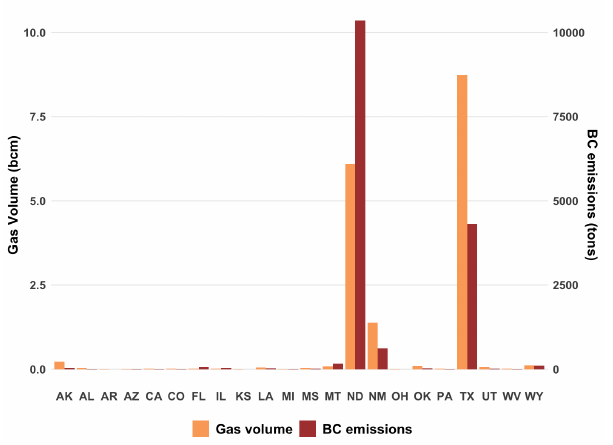
Figure 2. Flared gas volume (yellow bars) and BC emissions (red bars) by state in